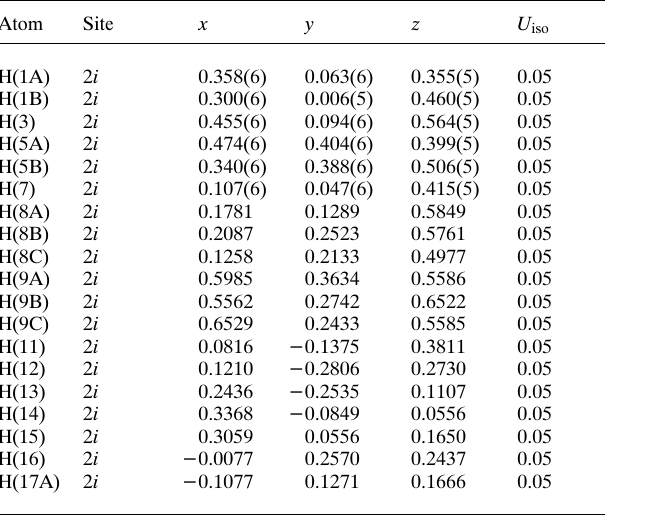
Table 2. Atomic coordinates and displacement parameters (in Å 2 ) .